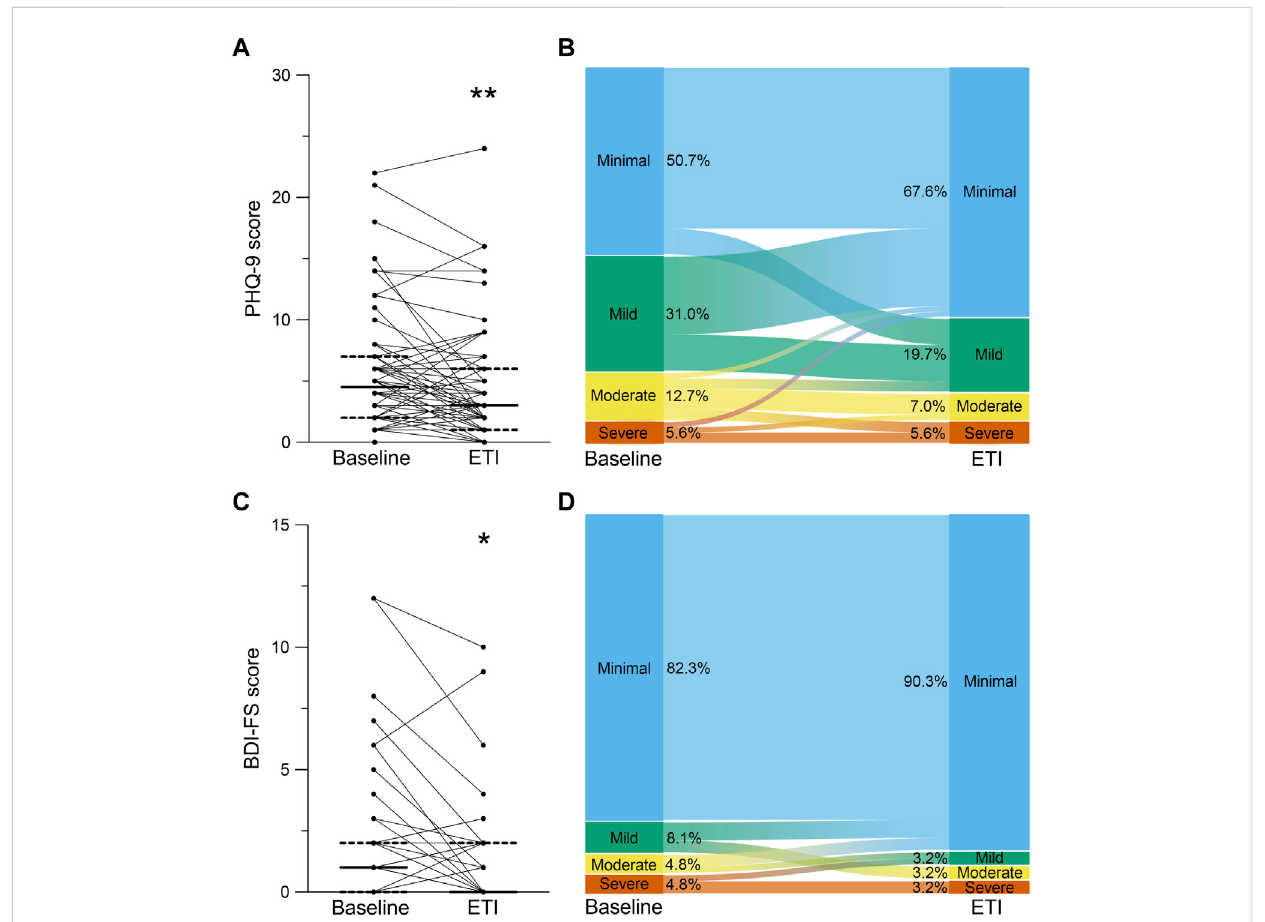
FIGURE 3 Effects of elexacaftor/tezacaftor/ivacaftor (ETI) on symptoms of depression. (A – D) Paired assessment of Patient Health Questionnaire-9 (PHQ-9) (A,B) and Beck ’ s Depression Inventory-FastScreen (BDI-FS) (C,D) in patients with CF and at least one F508del mutation at baseline and after initiation of ETI therapy. (B,D) Alluvial graphic depicting the proportions of the categories minimal (blue), mild (green), moderate (yellow) and severe (red) symptoms of depression assessed by PHQ-9 (B) and BDI-FS (D) in CF patients at baseline and after initiation of ETI therapy. Solid lines represent the group median and dashed lines represent 25th and 75th percentile. * p < 0.05 and ** p < 0.01 compared with